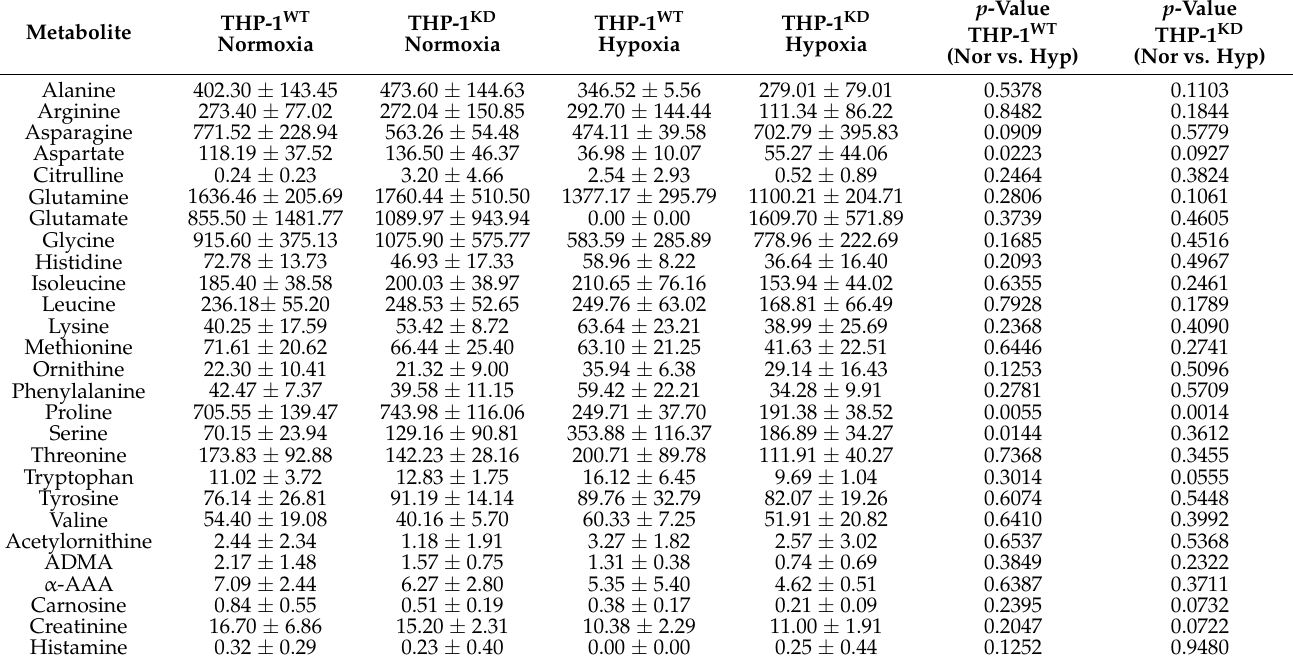
Table A3. Intracellular concentrations of metabolites in THP-1 WT and THP-1 KD cell